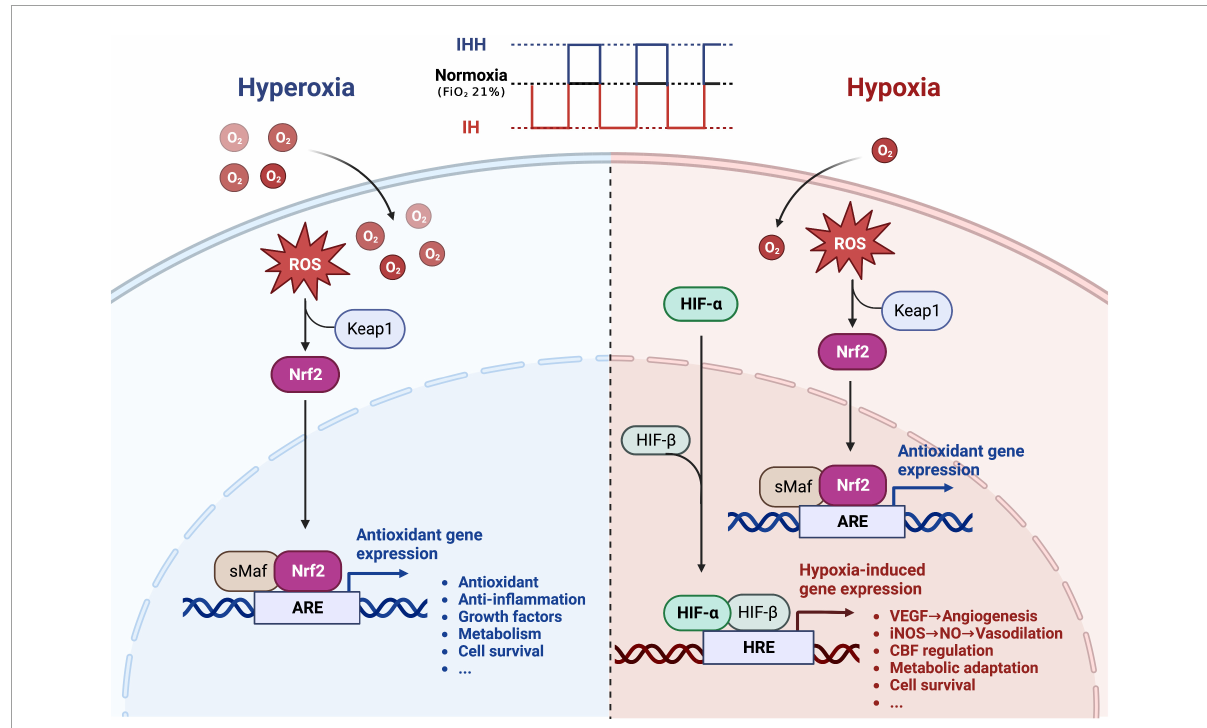
FIGURE1 The potential therapeutic benefit of intermittent hypoxia conditioning or intermittent hypoxia-hyperoxia conditioning for cerebrovascular protection. During intermittent hypoxia (IH) conditioning or intermittent hypoxia-hyperoxia (IHH) conditioning, moderate amounts of ROS are produced, activating the transcription factor Nrf2, which promotes the synthesis of protective proteins and improves the brain’s defense response to severe ischemic-hypoxic injury. In addition, hypoxia activates the transcription factor HIF, which induces numerous genes essential for cell metabolism, proliferation, and survival. Many of these genes play a central role in injury tolerance and promotion of tissue oxygenation, such as vascular endothelial growth factor (VEGF), and inducible NO synthase (iNOS). Replacing normoxia with hyperoxia during the reoxygenation phase can amplify the beneficial effects of intermittent hypoxia. ROS, reactive oxygen species; Nrf2, nuclear factor erythroid 2-related factor 2; ARE, antioxidant response element; HIF, hypoxia-inducible factor; HRE, hypoxia-responsive element. Created with